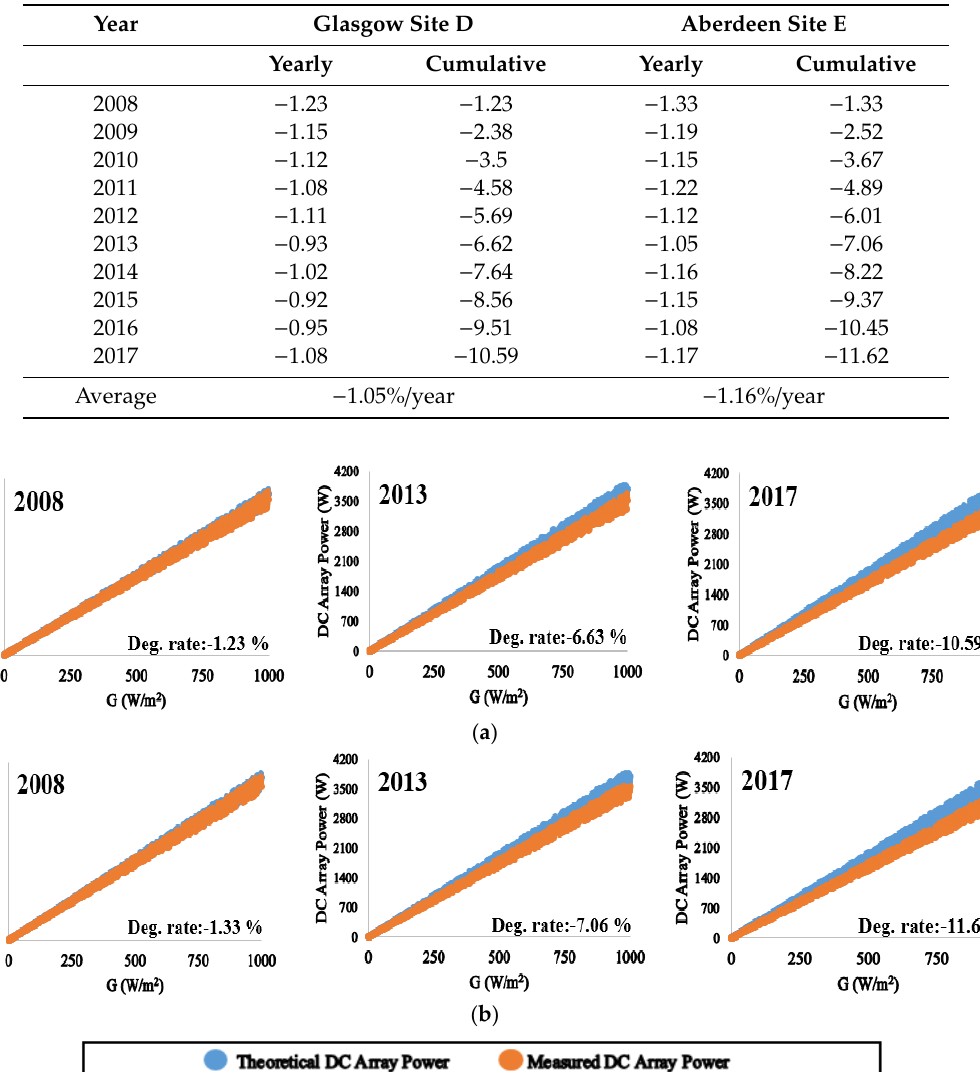
Figure 4. Example showing the impact of hoarfrost and heavy snow on PV modules: ( a ) PV module glass damage observed at Aberdeen site (PV site E) due to a hoarfrost weather event; ( b ) hot spots captured in two different PV modules at Glasgow site (PV site D) after a heavy snow weather event. Table 4. Scotland PV systems’ Degradation Rate Analysis.